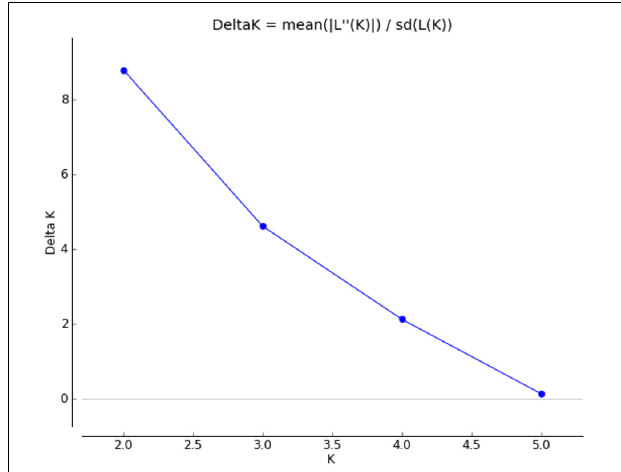
FIGURE 7 | Graphical illustration of delta K